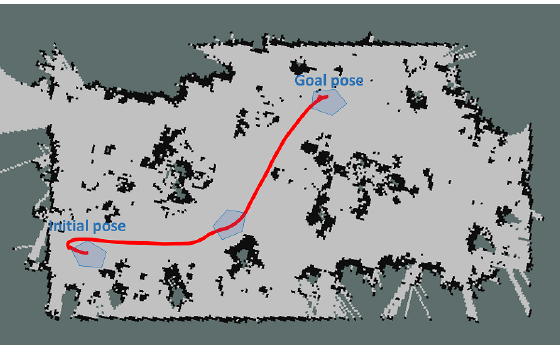
Figure 13. An example of autonomous movement between the starting point and the goal